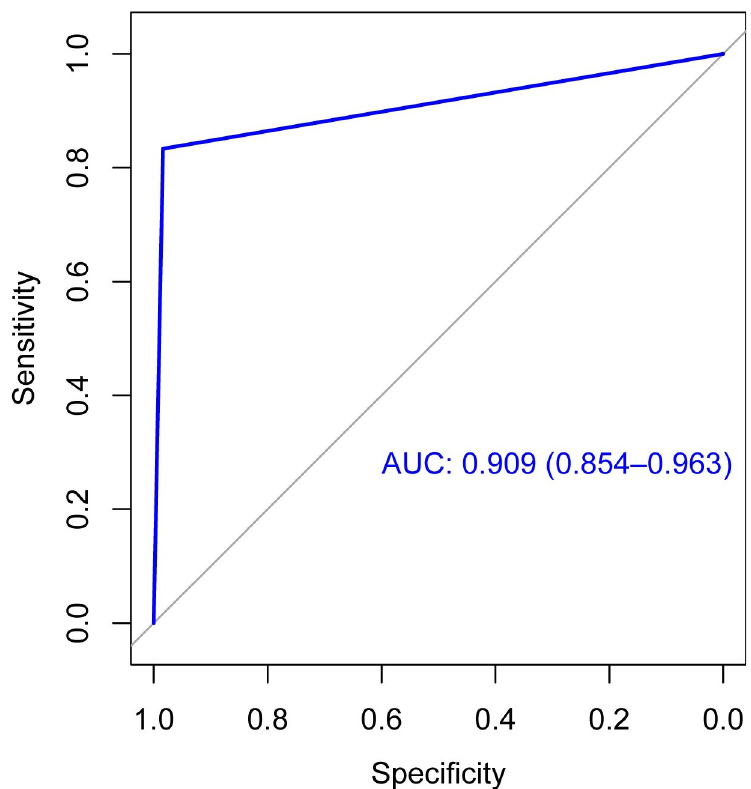
Fig 2. Receiver operating characteristic curves. Receiver operating characteristic curve for pelvic magnetic resonance imaging (MRI) for diagnosing bone marrow involvement in patients with diffuse large B-cell lymphoma.